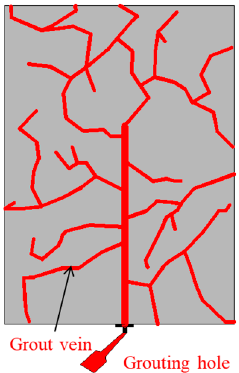
Figure 7. Grouting diagram.